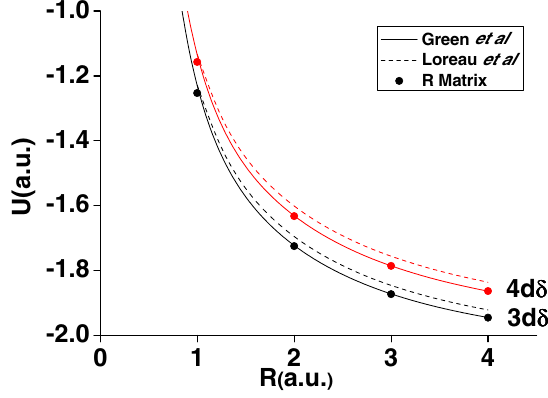
Figure 2. Clamped-nuclei potential energy curves of the 3˜ d (cid:5) (black symbols) and 4˜ d (cid:5) (red symbols) 1 (cid:1) states of the HeH + ion. The present results (dots) are compared with those of Refs. [1] (solid line) and [3] (dashed line). as the latter are characterized by small quantum defects, | n − ν | (cid:5) 1. The electronic n ˜ d (cid:5) states of HeH + do of course not correspond to pure ˜ d Rydberg states but they are labeled in Tables 1 and 2 according to the main component in the multichannel wave function. Inspection of the eigenvectors obtained in the MQDT calculations indicates that in fact (depending on the choice of Z 1 and Z 2 [see Sect. 2]) there